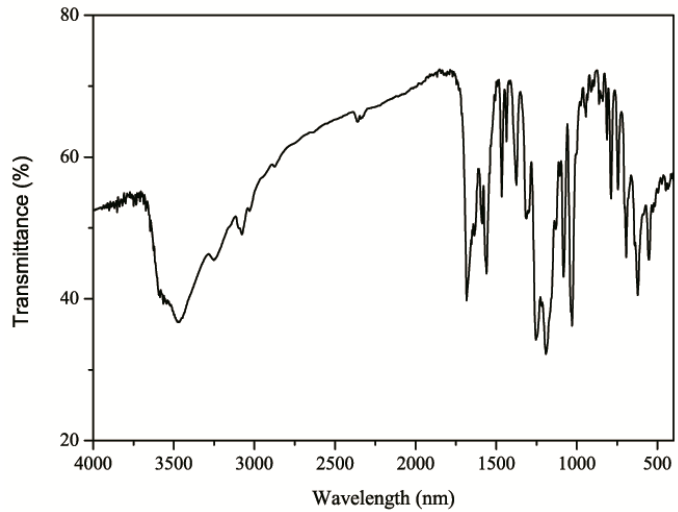
Figure 1. The IR spectrum of 1 .